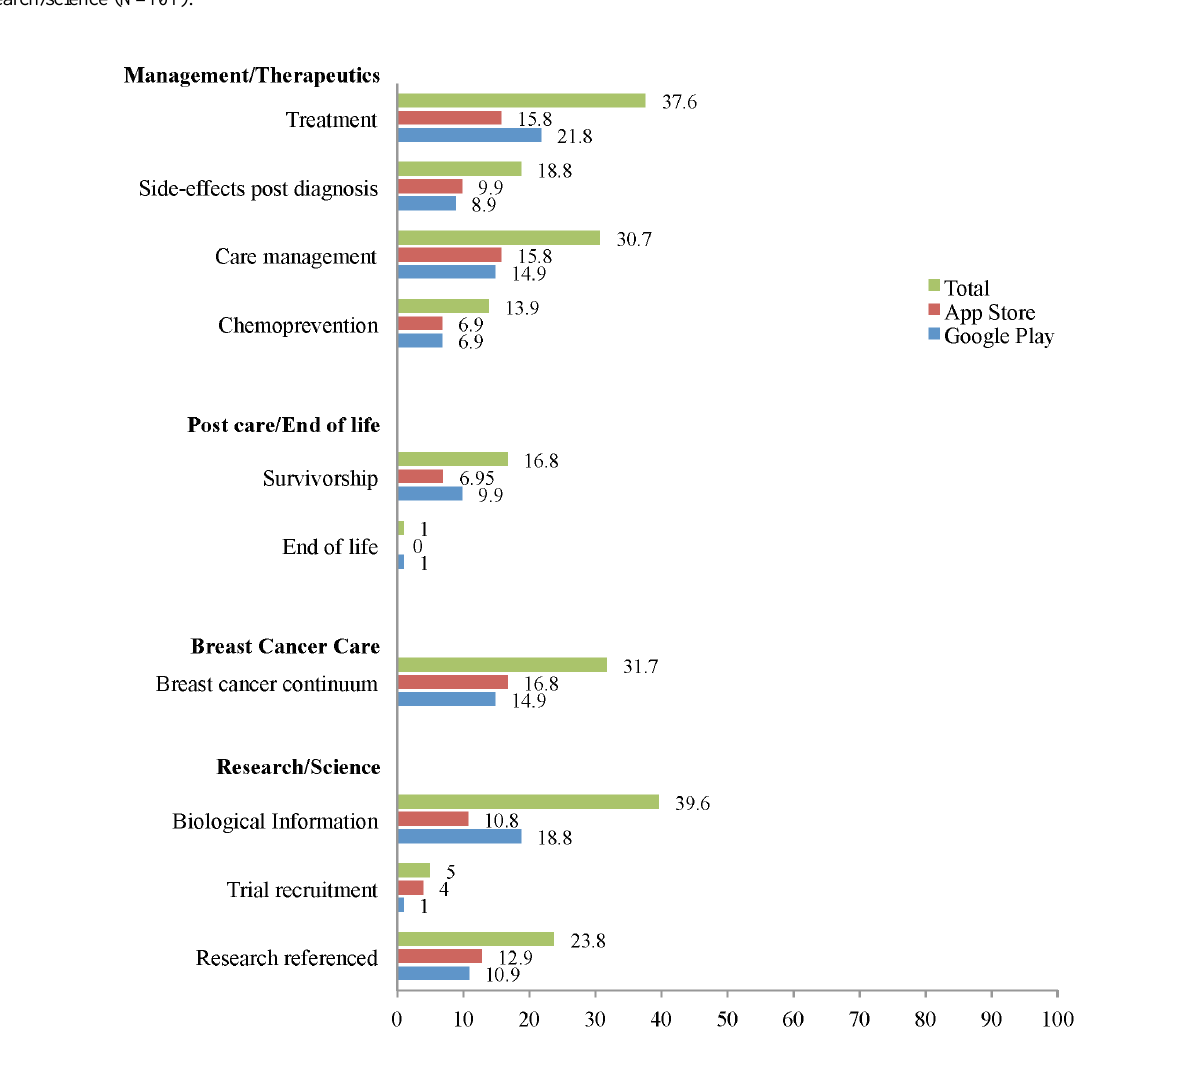
Figure 3. App characteristic percentages on App Store and Google Play: management/therapeutics, postcare/end of life, breast cancer care, and research/science